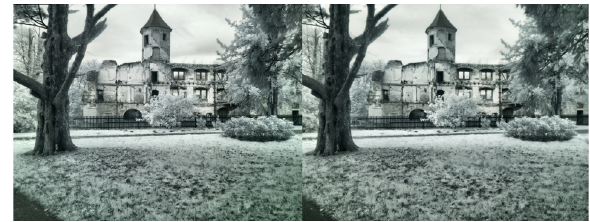
Figure 10: Infrared stereo image after channel mixing